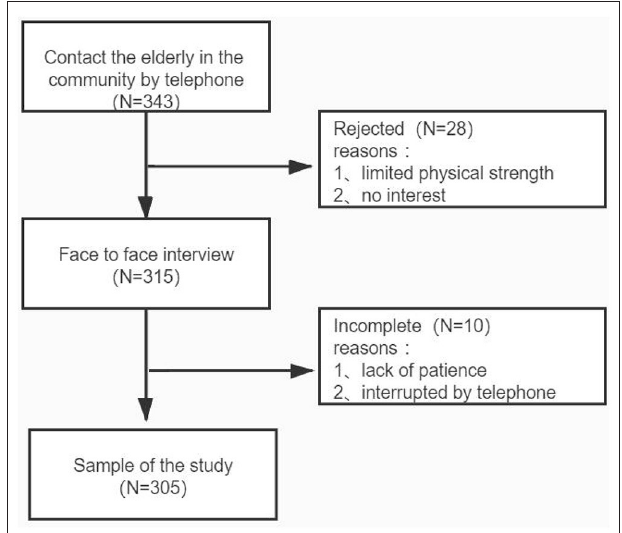
FIGURE 1 | Participant screening